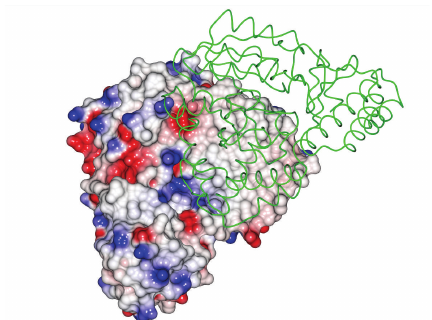
Figure 2: The structure of the Sulfolobus transaminase dimer showing one subunit in surface space filling mode where the white regions indicate hydrophobic regions and blue indicates basic regions and red acidic regions. The other subunit is represented as a 𝛼 -C chain showing that the subunit interface is mainly hydrophobic (PDB code 3ZRP). The figure was constructed using CCP4mg [53].